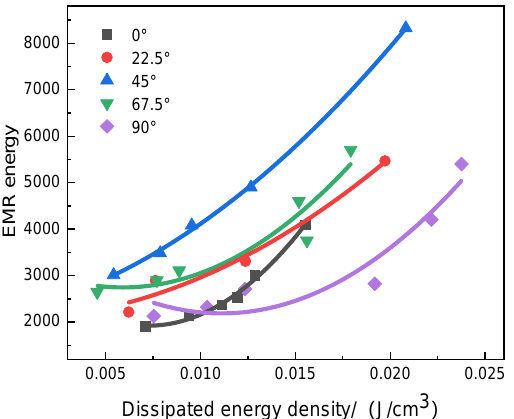
Figure 11. The relationship curve between EMR energy and dissipated energy density.